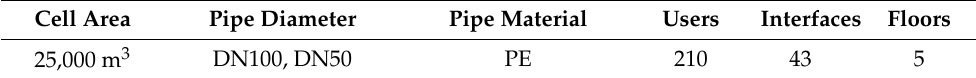
Table 1. Basic information of S-cell.